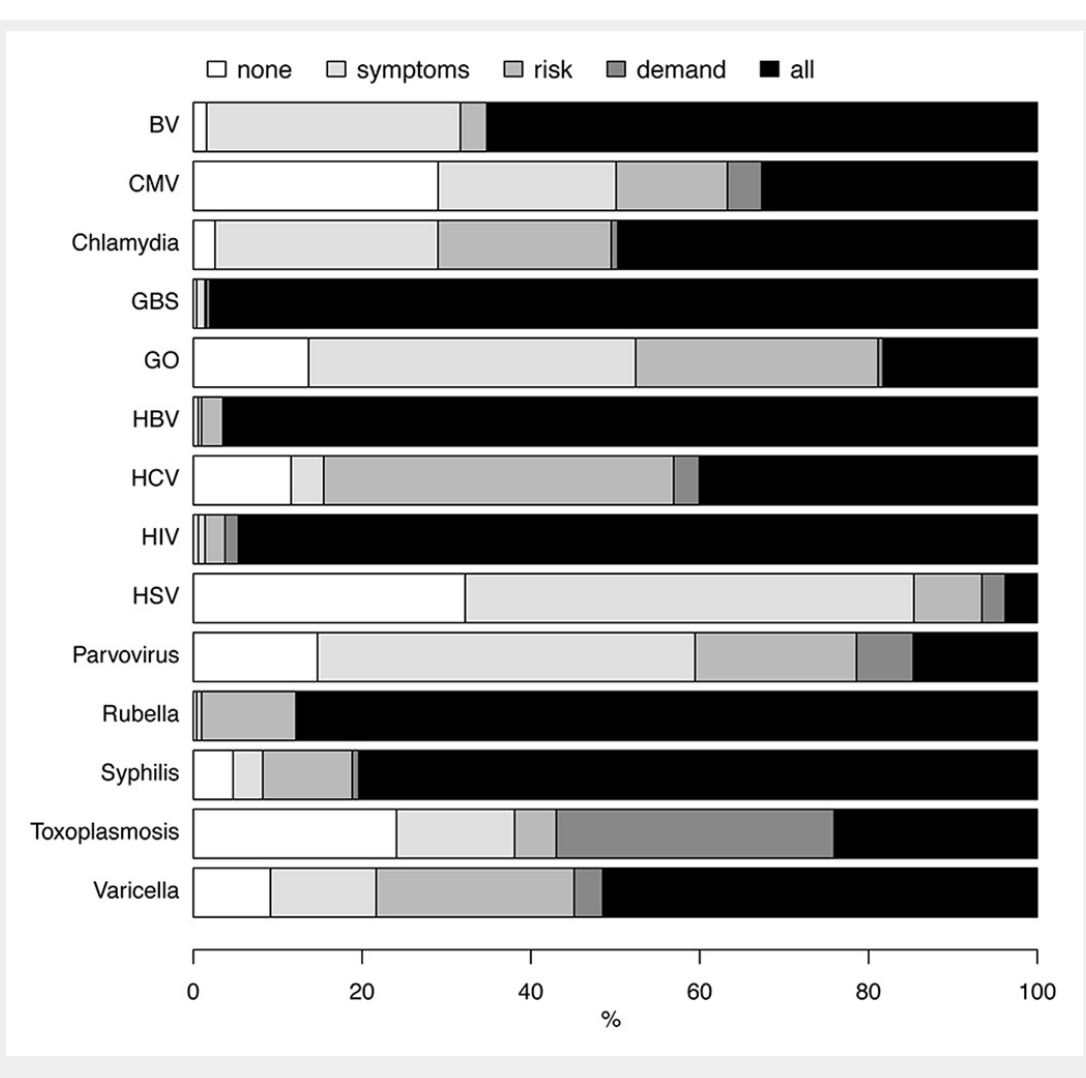
Figure 1 Testing practice for each infection, percentage of respondents reporting each practice. None = no testing for this infection; symptoms = test only women with symptoms; risk = test only women with specific risk factors; demand = test women who request it; all = test all women for this infection BV = bacterial vaginosis; CMV = cytomegalovirus; GBS = group B streptococcus; GO = gonorrhoea; HBV = hepatitis B virus; HCV = hepatitis C virus; HIV = human immunodeficiency virus; HSV, herpes simplex